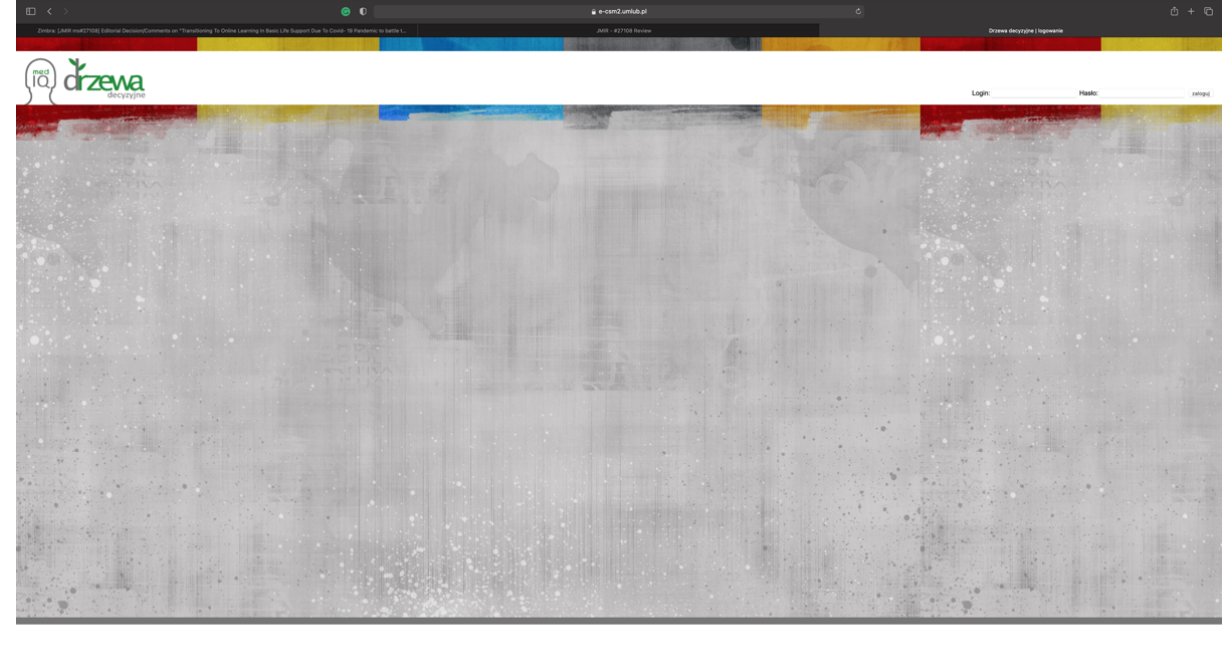
Figure 6. A screenshot of a login website for accessing the decision